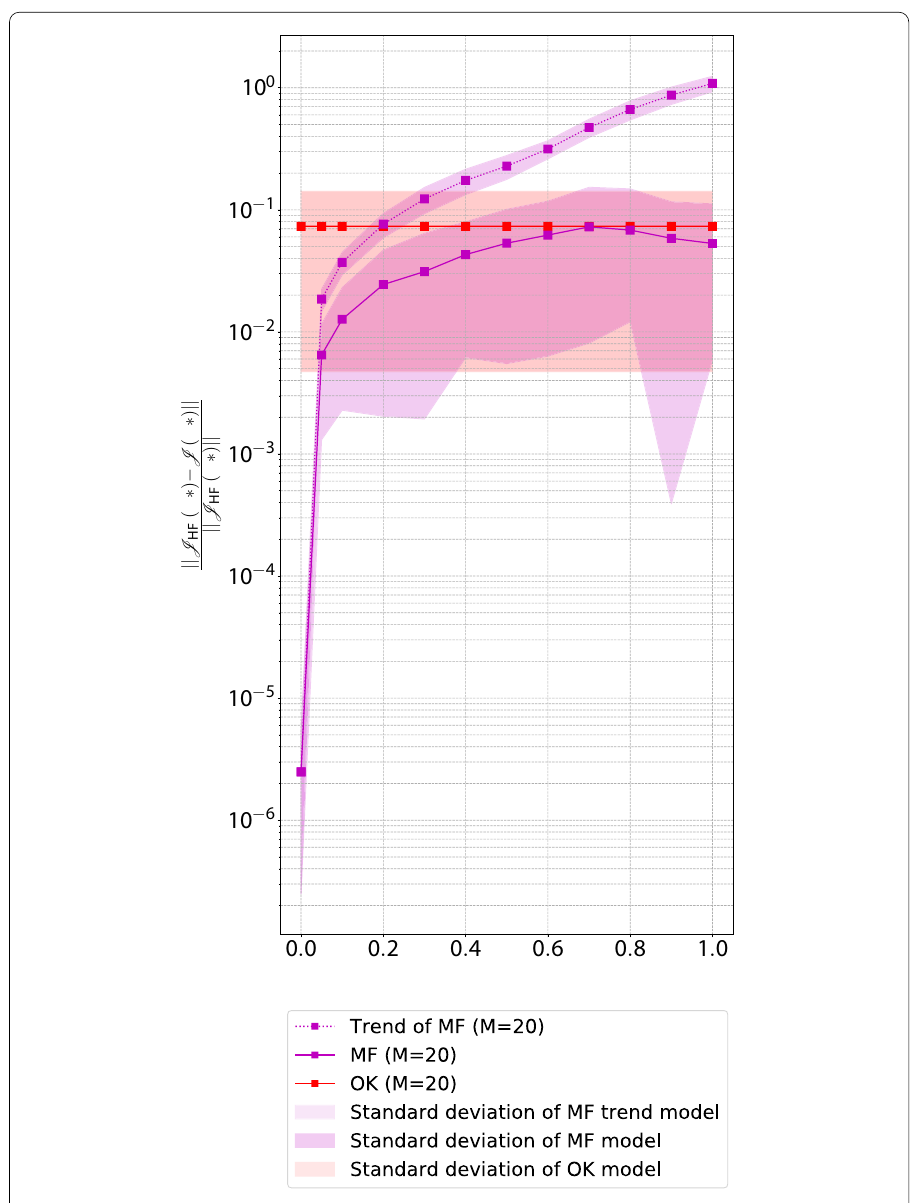
Fig. 7 Evolution of the relative error at the theoretical optimal point for multiple runs. The mean error values are represented by purple continuous and dotted lines for the MF model and its trend, the OK by a red line, with their corresponding standard deviation (shaded areas) obtained from 40 independant LHS experiments for each α value. Same LHS DoE is used for model